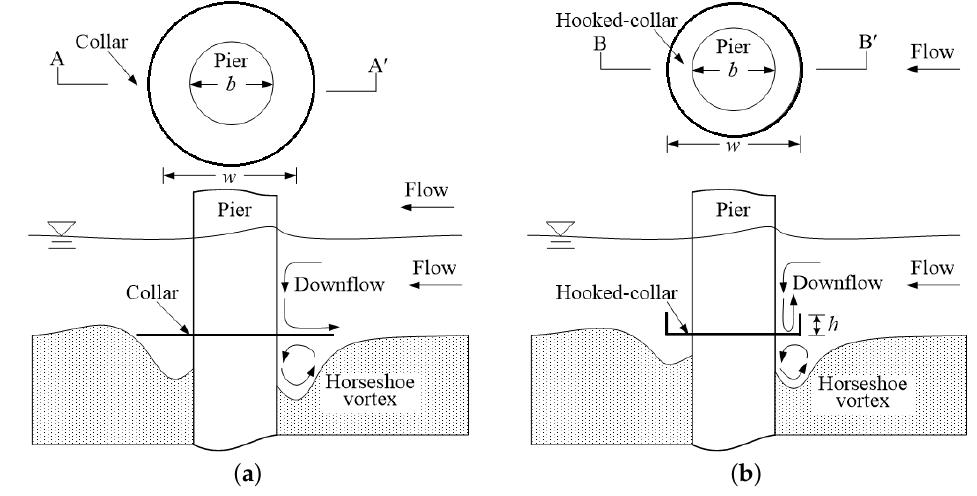
Figure 1. Flow features around piers: ( a ) pier fitted with a collar; and ( b ) pier fitted with a